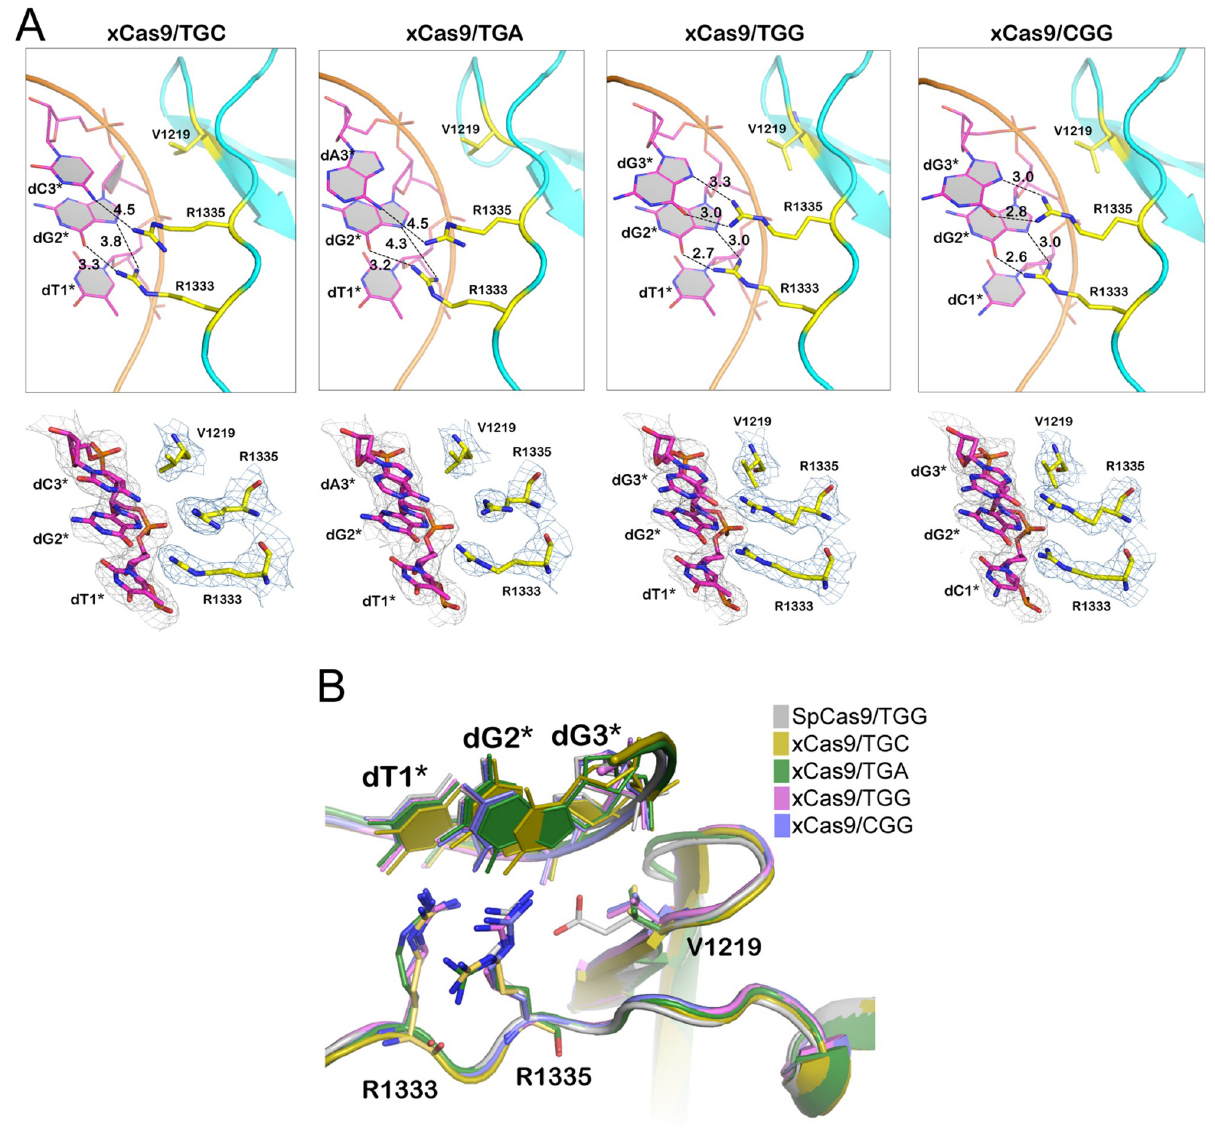
Fig 4. Structural insight into PAM recognition by xCas9. (A) Zoom-in views of PAM recognition by xCas9 in complex of TGC, TGA, TGG, and CGG PAMs, respectively. Upper panel: cartoon-view of PAM recognition in xCas9. Lower panel: The 2F o -F c electron density maps for the PAM nucleotides and V1219, R1333, and R1335 residues are contoured at 1.0 sigma level. (B) Superimposition of PAM recognition sites of the TGG PAM-bound SpCas9 with those of TGC, TGA, TGG, and CGG PAM-bound xCas9. PAM, protospacer adjacent motif; SpCas9, Streptococcus pyogenes